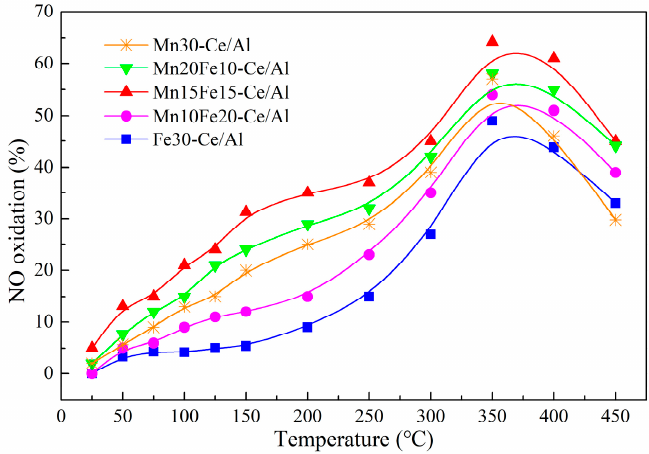
Figure 8. The activity of NO oxidation into NO 2 over Mn − Fe − Ce − O x / γ ‐ Al 2 O 3